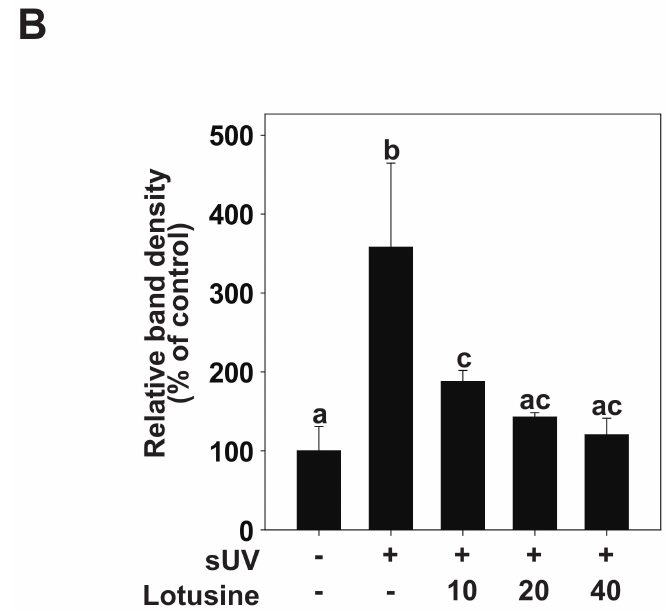
Figure 2. Lotusine inhibits solar ultraviolet (sUV)-induced MMP-1 protein expression in HaCaT cells. ( A ) HaCaT cells were pretreated with lotusine at indicated concentrations for 1 h and further treated with 25 kJ/m 2 sUV for 48 h at 37 ◦ C. ( B ) MMP-1 protein expression data for HaCaT cells were quantified using Image Studio software (LI-COR, NE). Data ( n = 3) are presented as mean ± standard deviation (SD). Bars marked with different letters (a–c) significantly differ ( p < 0.05) according to Duncan’s multiple range test. MMP-1, matrix